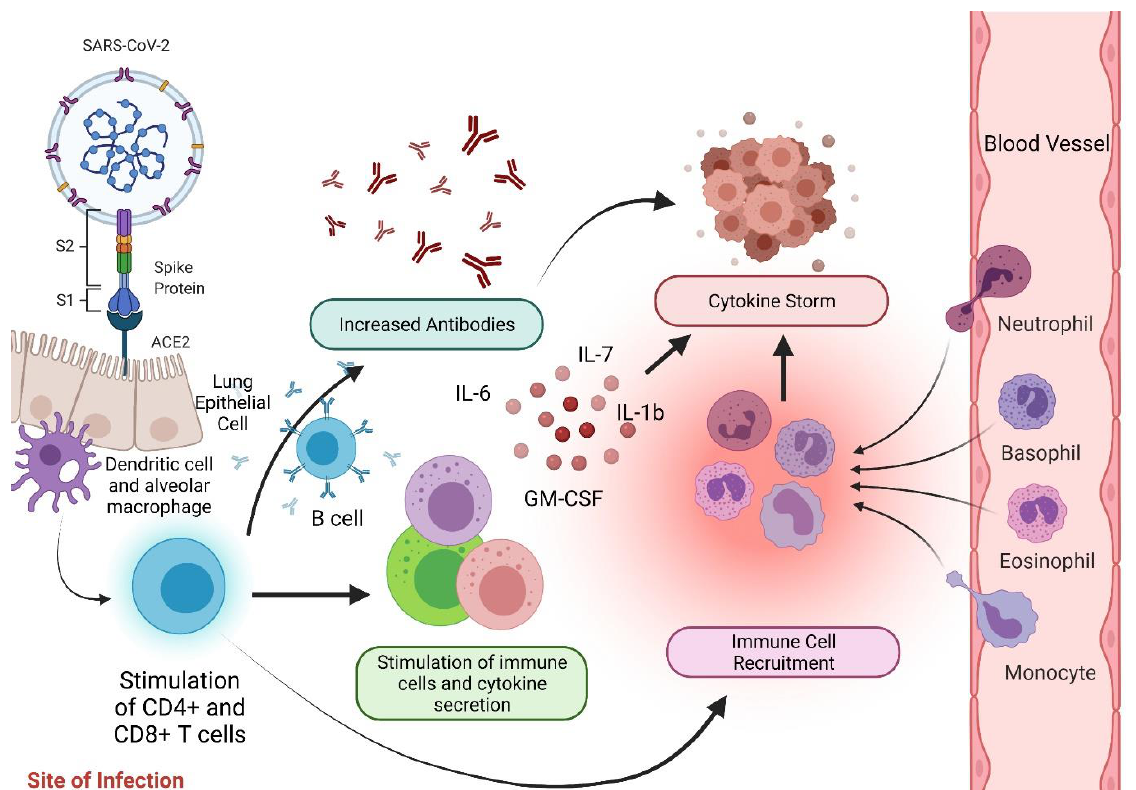
Figure 2. The immunopathology of COVID-19.